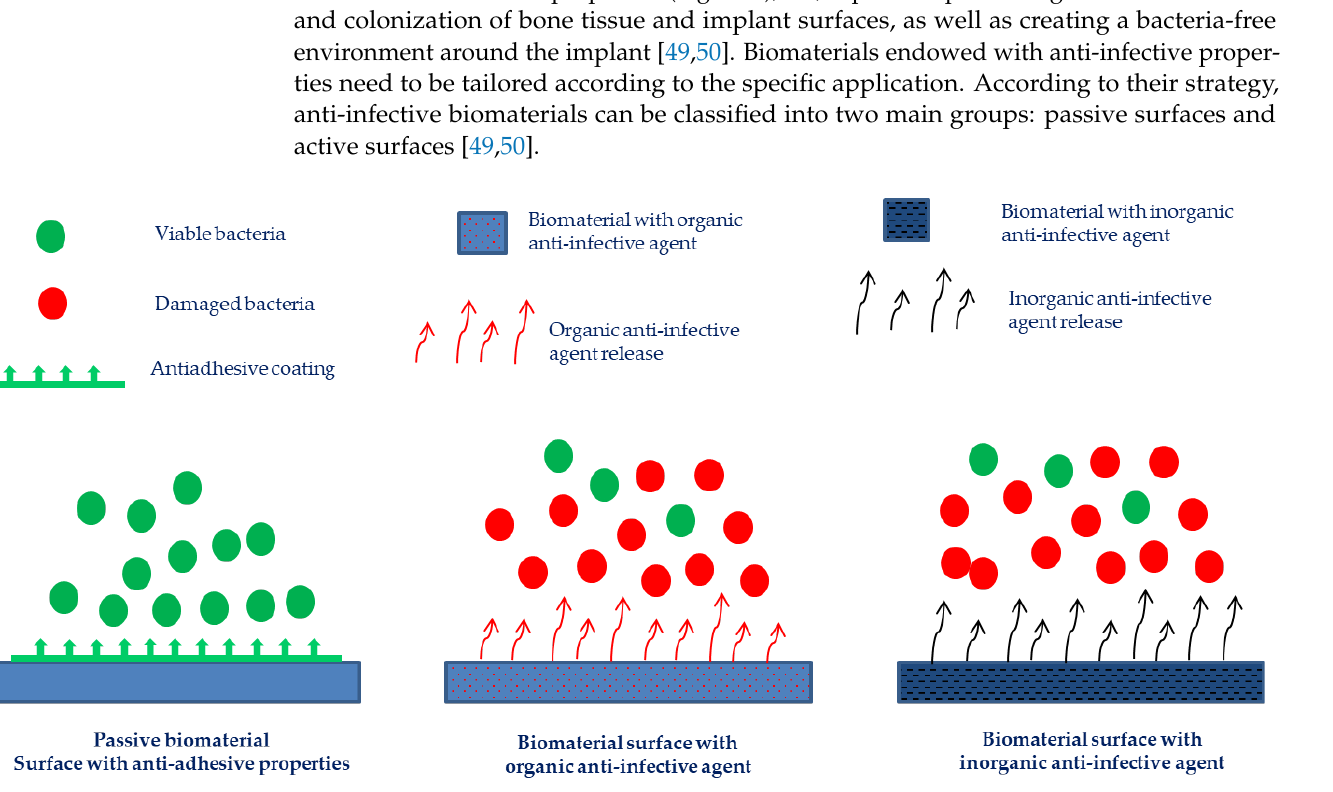
Figure 2. Different strategies have been developed to trigger anti-infective activity in biomaterials. Passive (anti-adhesive) surfaces are those presenting chemistry and/or structure modifications that aim at preventing or reducing bacterial adhesion, without releasing bactericidal agents into the surrounding tissues. Active surfaces have in their composition pre-coated antimicrobial agents such as organic substances (antibiotics and anti-infective peptides, bacteriophages), metals or metal ions (silver, zinc, copper, among others), and/or their combinations, that may inhibit microbial colonization and biofilm formation.